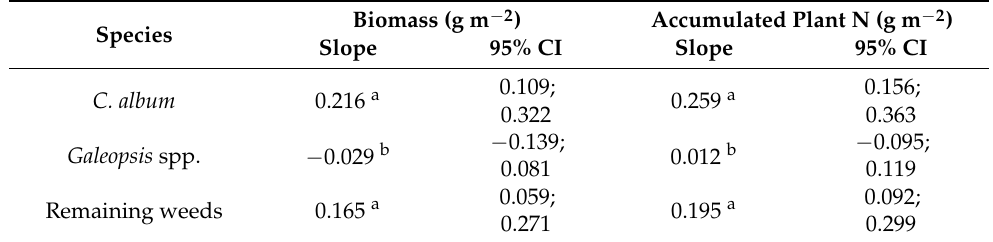
Table 4. Slope estimates and 95% confidence intervals for the regressions of weed species biomass and accumulated N over N availability presented in Figure 4. Different letters indicate significant different slopes following a pairwise comparison (Tukey, α =